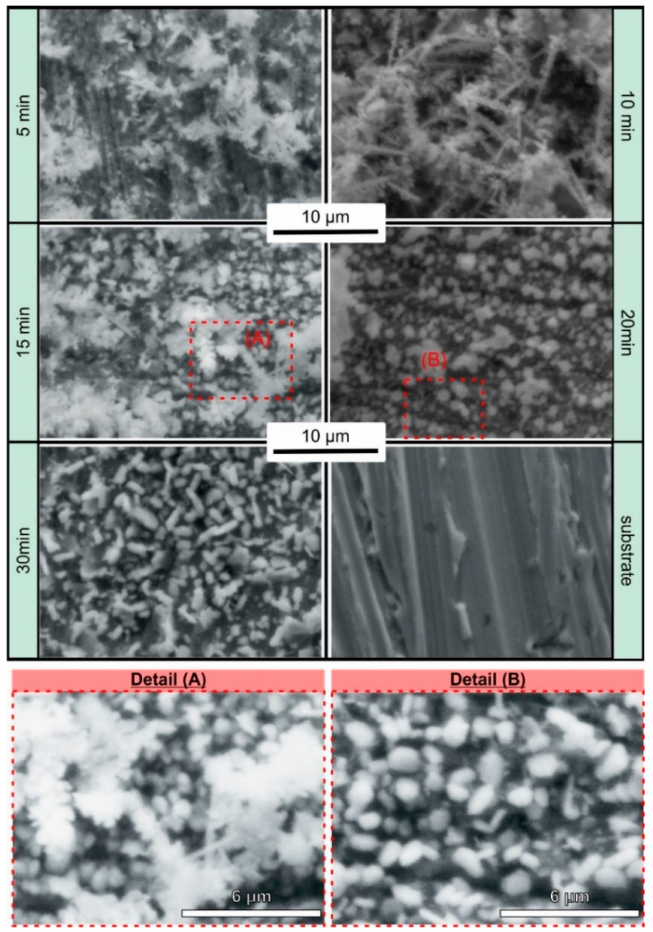
Figure 3. Scanning electron microscope (SEM) images of hydrophobic silver coatings produced using different immersion durations in silver nitrate solution and pH 10 for the Tris buffer